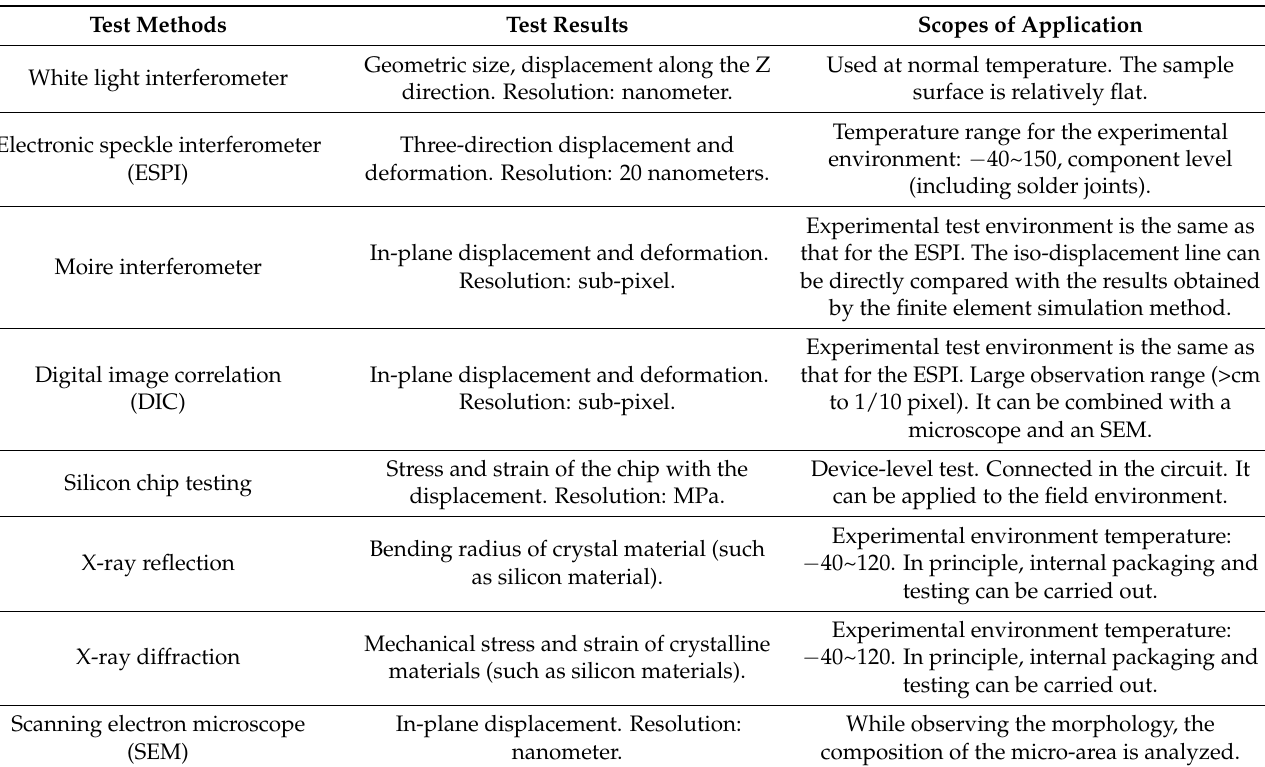
Figure 3. Main failure modes of BGA solder joints. Table 2. Common test methods